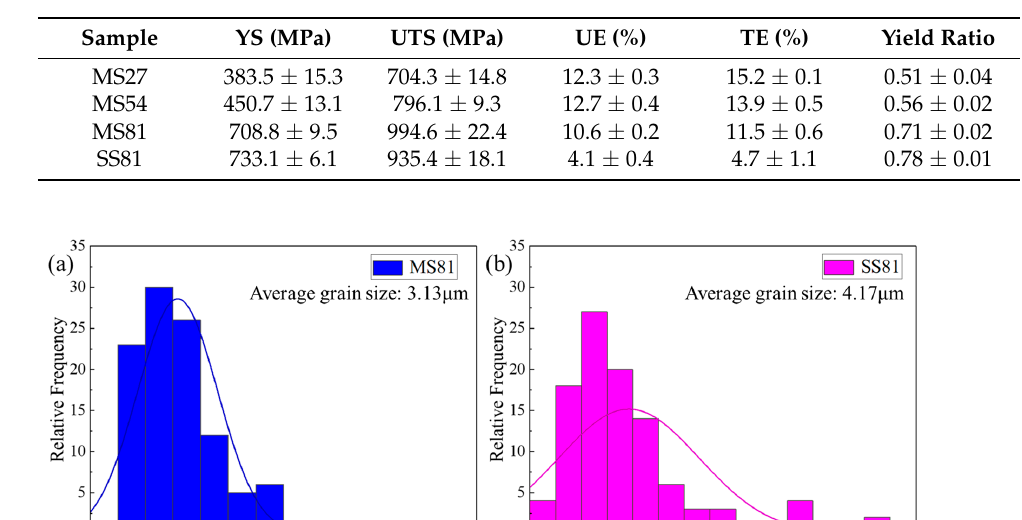
Figure 5. Ferrite grain distribution in ( a ) MS81 and ( b ) SS81.